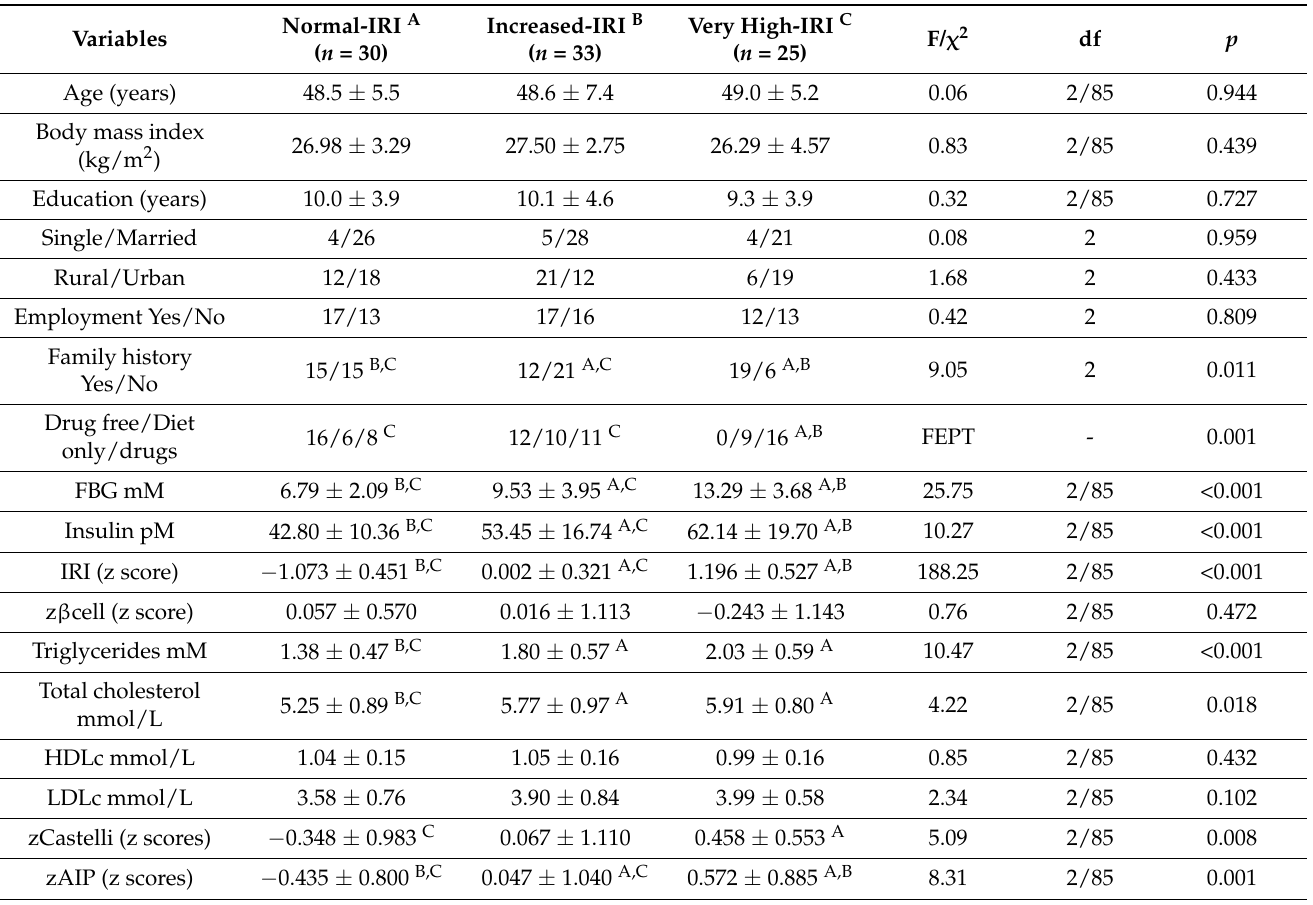
Table 1. Socio-demographic and clinical data in patients with T2DM subdivided according to the insulin resistance index (IRI) values into normal IRI values, medium increased IRI, and very high IRI